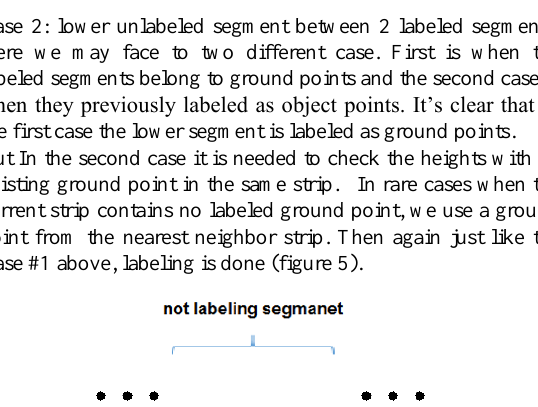
Figure 4. not labebled segment between 2 labelled segments with higher elevation.